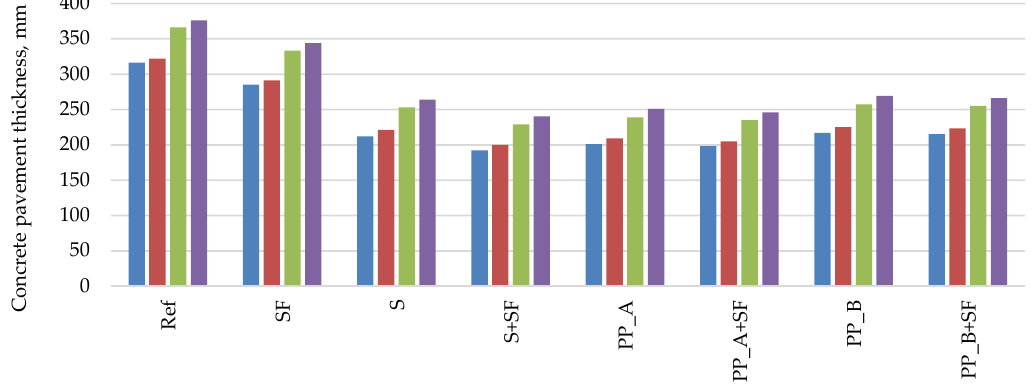
Figure 1. The minimum PCP thickness calculated by the RDO Beton 09 method.